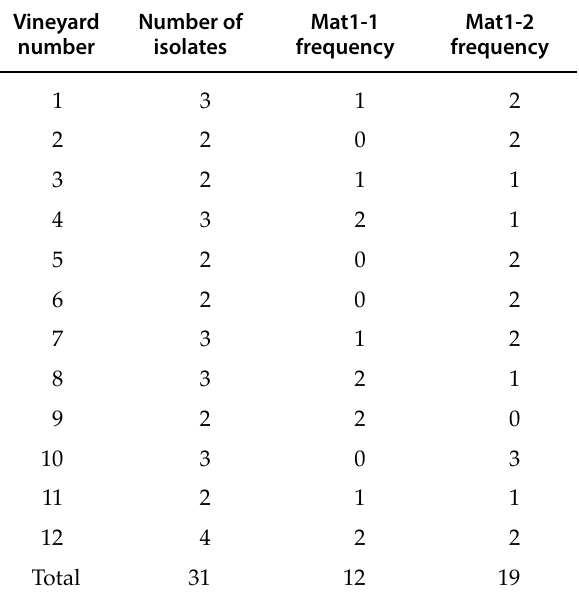
Table 3. Validation of multiplex PCR method developed for screening of mating types in Togninia minima on field isolates collected from 12 vineyards in the Azarshahr region (East Azerbaijan province,